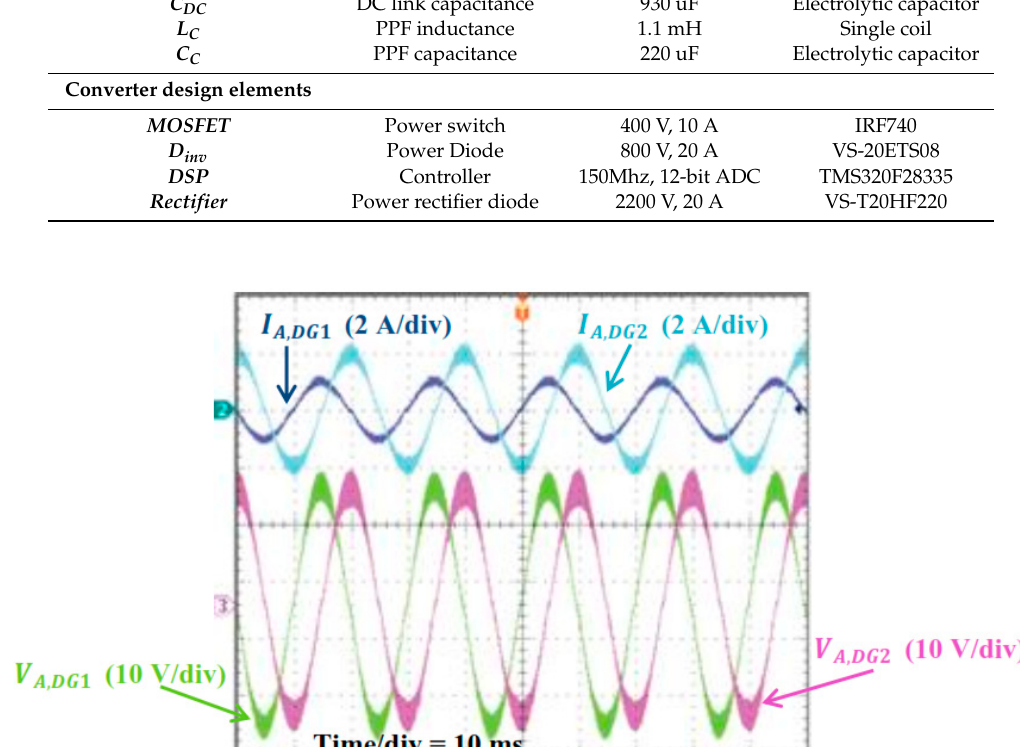
Figure 8. Experimental results of droop controller: ( dark blue trace ) DG 1 output current, ( light blue trace ) DG 2 output current, ( green trace ) DG 1 output voltage, ( pink trace ) DG 2 output voltage.